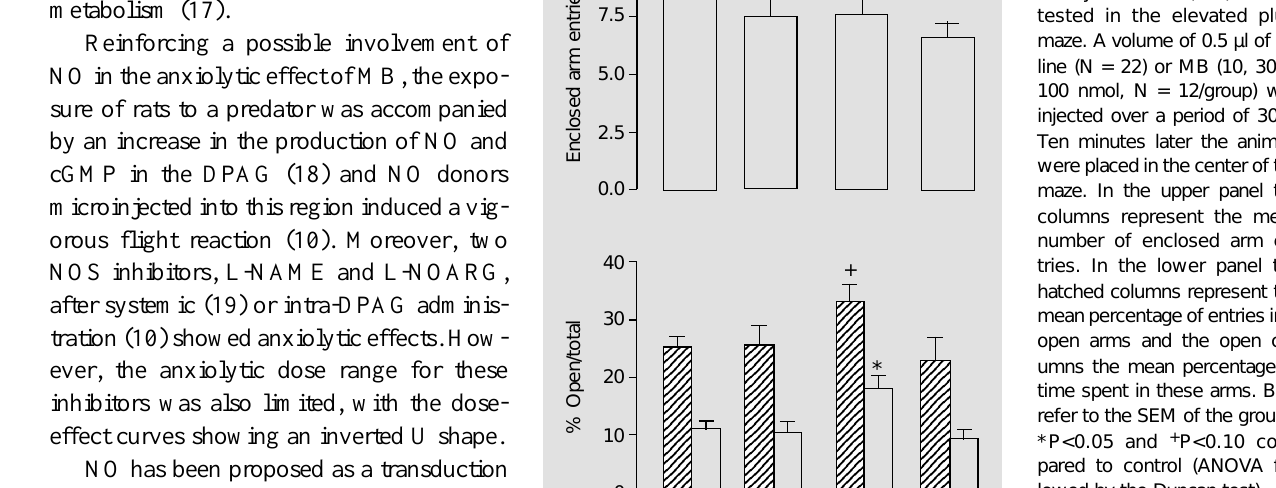
Figure 1 - Anxiolytic effect of intra-DPAG microinjection of methylene blue (MB) in rats tested in the elevated plus- maze. A volume of 0.5 µl of sa- line (N = 22) or MB (10, 30 or 100 nmol, N = 12/group) was injected over a period of 30 s. Ten minutes later the animals were placed in the center of the maze. In the upper panel the columns represent the mean number of enclosed arm en- tries. In the lower panel the hatched columns represent the mean percentage of entries into open arms and the open col- umns the mean percentage of time spent in these arms. Bars refer to the SEM of the groups. *P<0.05 and + P<0.10 com- pared to control (ANOVA fol- lowed by the Duncan